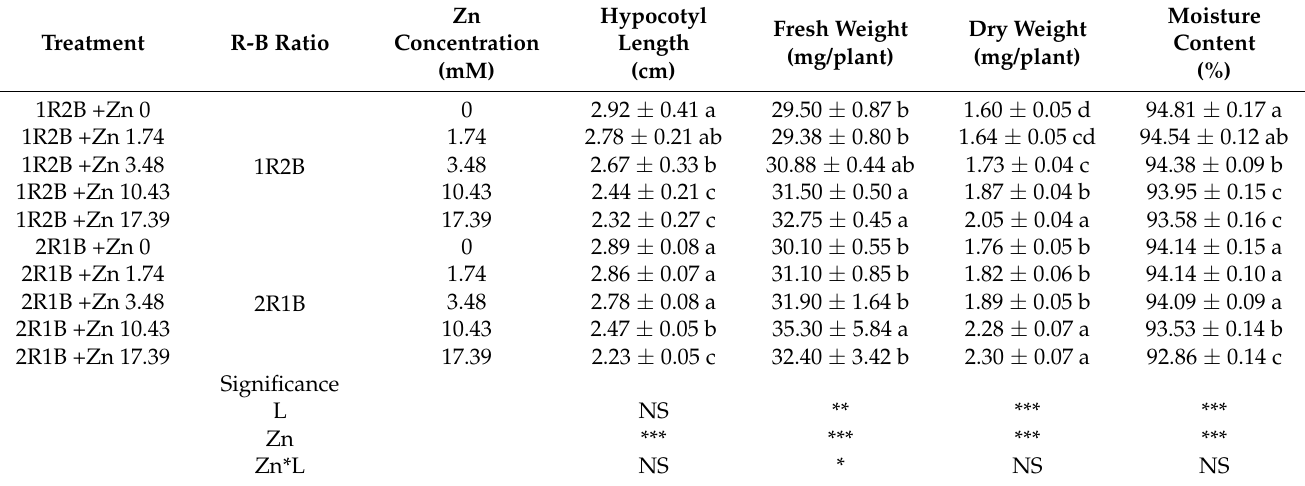
Table 1. Growth of flowering Chinese cabbage sprouts (FCCS) under combination of Zn concentration and R-B